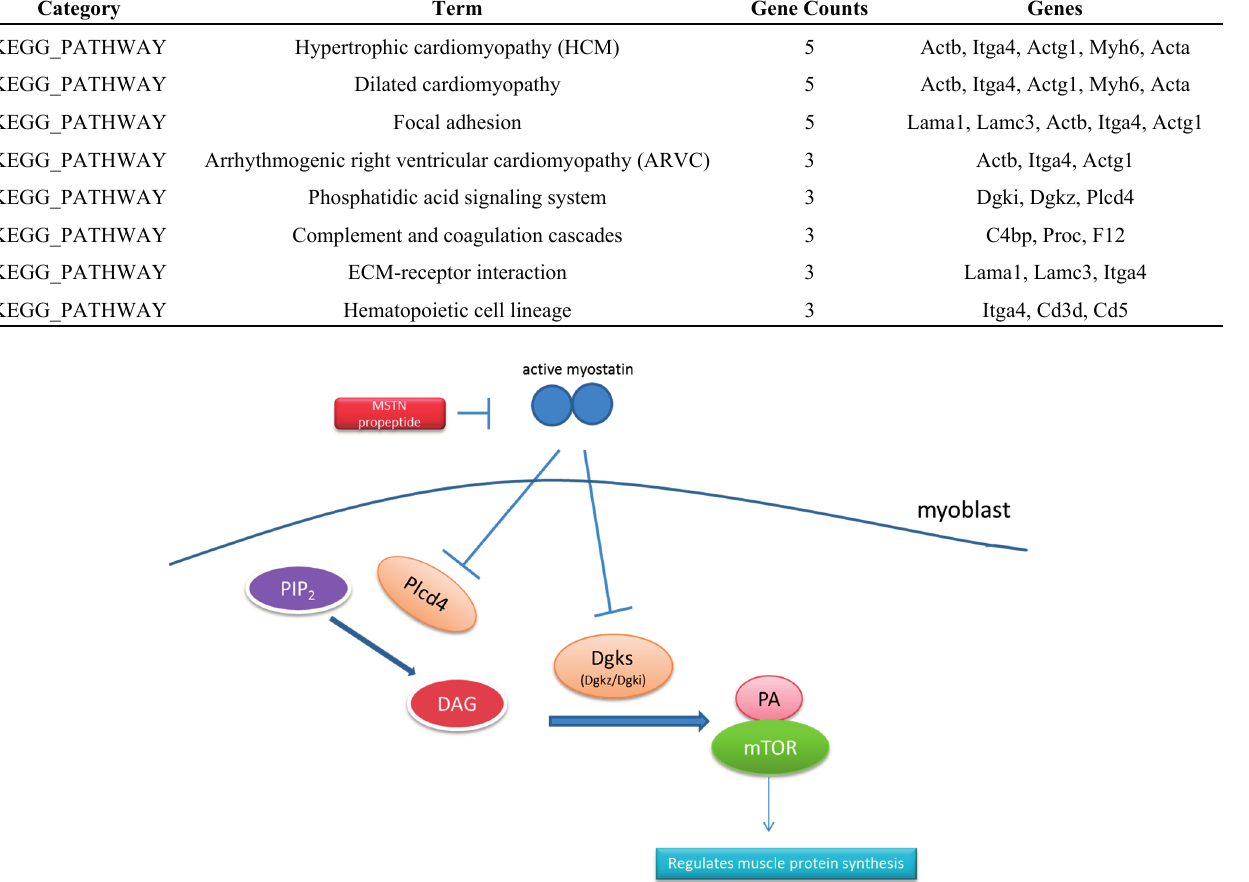
Figure 6. A theoretical model of the negative regulation of the PA signal pathway by myostatin in skeletal muscle. Plcd4 can catalyze hydrolyzes